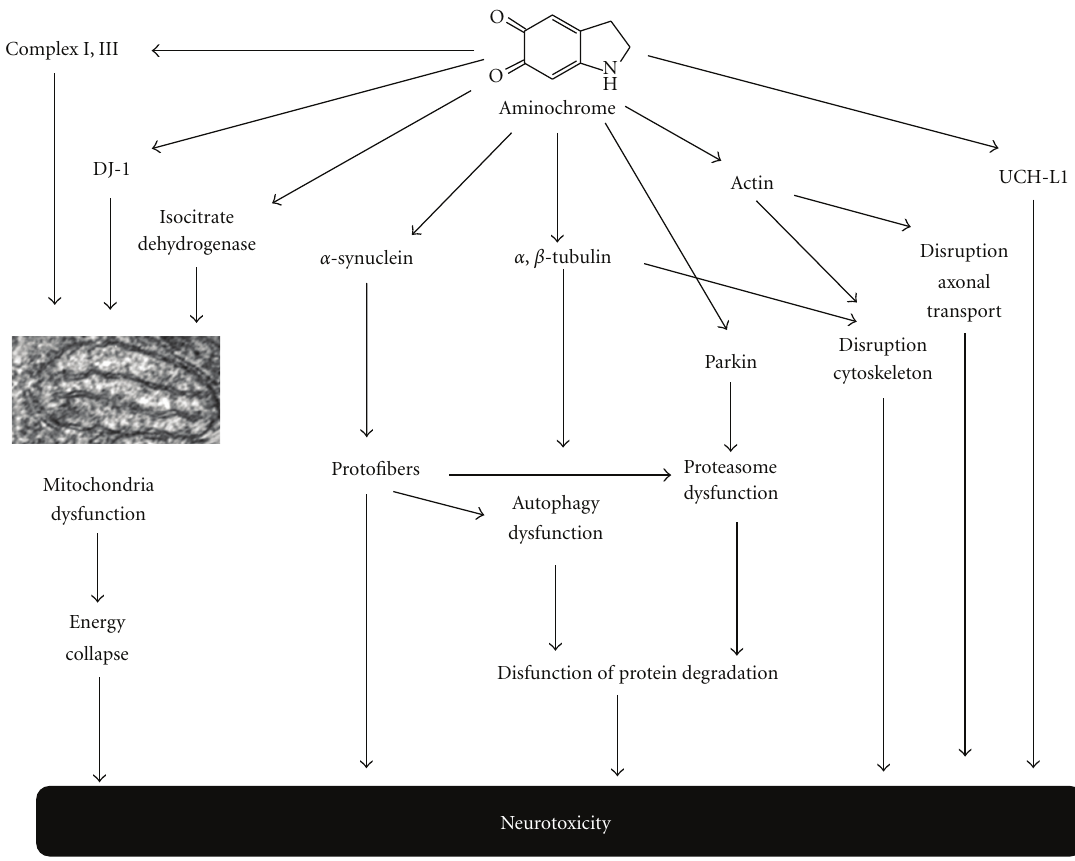
Figure 5: Aminochrome forms adducts with proteins. Aminochrome forms adducts with proteins, such as DJ-1, isocitrate dehydrogenase, and complex I and III of mitochondria, inducing mitochondrial dysfunction and an energy collapse. Adducts formed with α -synuclein, induces the formation of neurotoxic α -synuclein protofibrils, which inactivate chaperone-mediated autophagy and impair the proteasomal system, resulting in the dysfunction of protein degradation. Aminochrome adducts formed with α - and β -tubulin induces the aggregation of microtubules that are required for the fusion of autophagy vacuoles with lysosomes. Aminochrome also forms adducts with